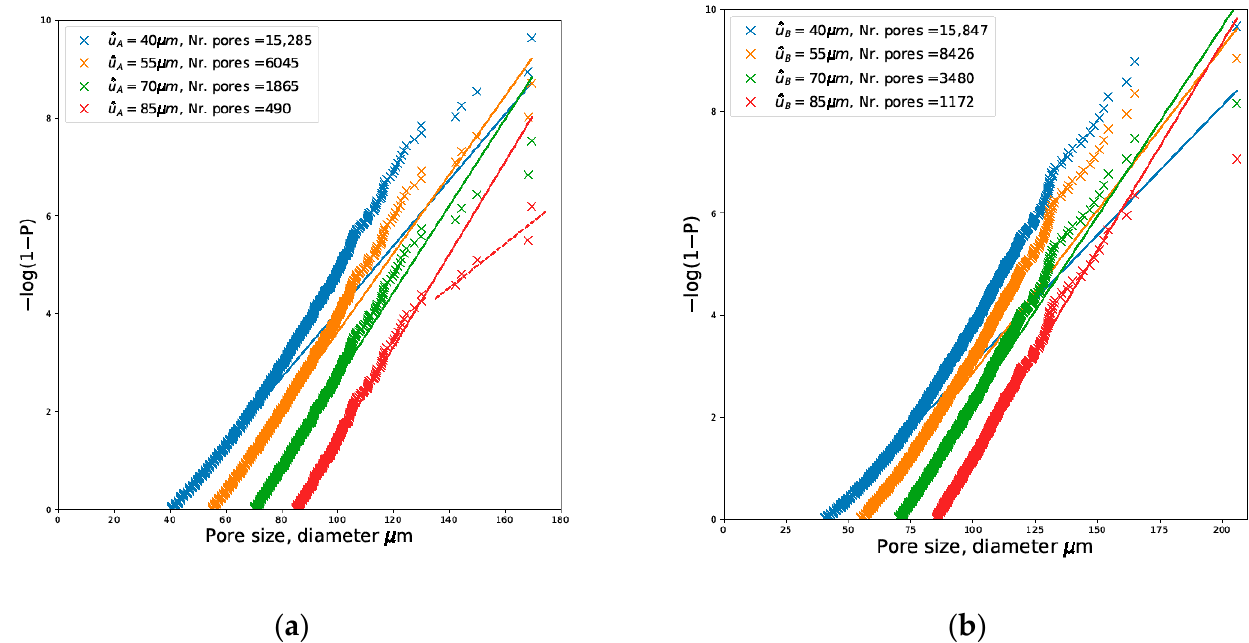
Figure 9. Linear fits to the probability plots of XCT data from Build A at various cut-offs. ( a ) Build A; the dashed line shows an example of a potential secondary linear fit to the extreme values of the distribution. ( b ) Build